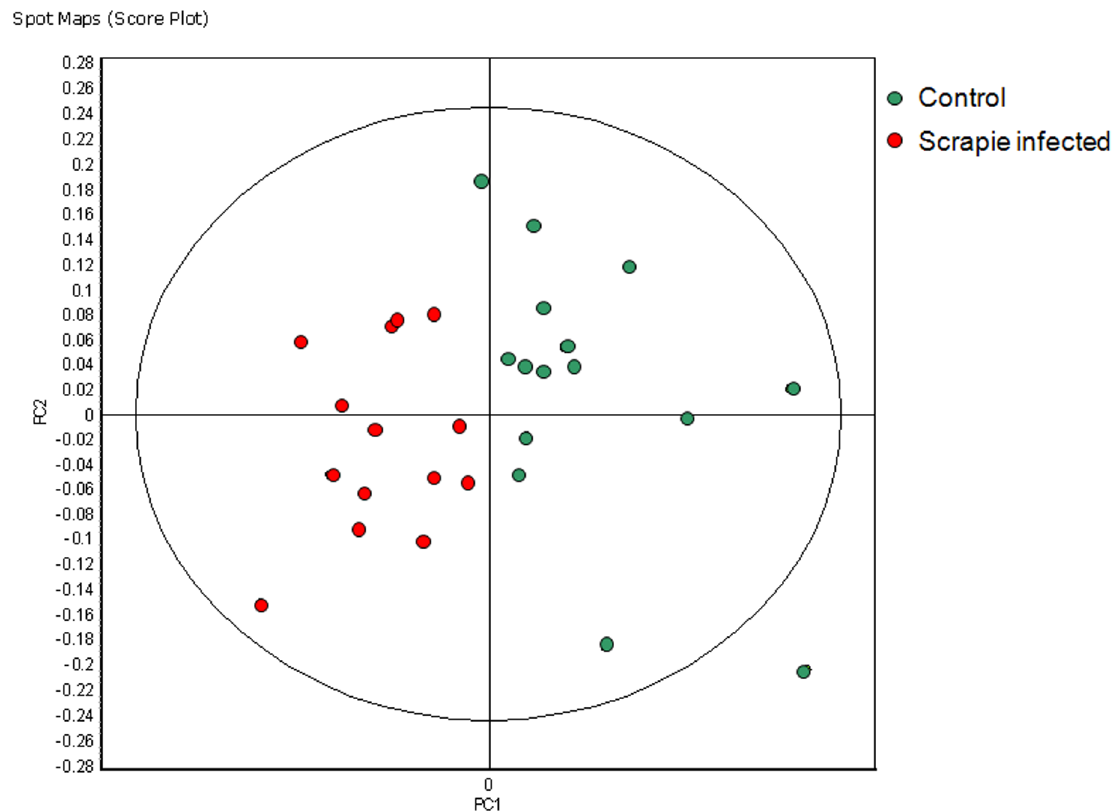
Figure 1. Principle Component analysis of the 14 scrapie infected (red) and 15 control samples (green) collected from 4 control and 4 infected mice at 4 time points: 11, 13, 15 and 17 weeks post infection (wpi). Samples not collected were one infected sample at both 11 and 15 wpi and one control sample at 13 wpi. A classifier based on 2 features was able to correctly classify the 29 samples of the training set with 100% accuracy. (PC1=87.4,